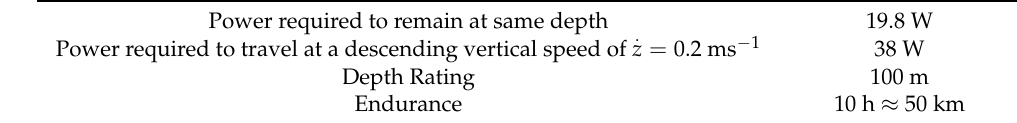
Table 1. Main characteristics of the MARES AUV.